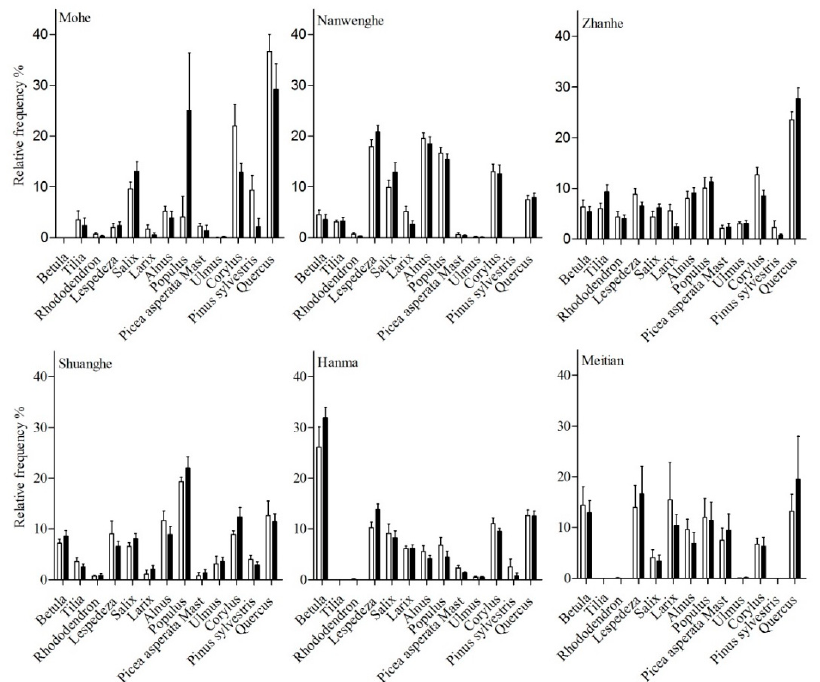
Figure A1. Dry weight (DW; %) of female (white) and male (black) moose diet in Mohe, Nanwenghe, Zhanhe, Shuanghe, Hanma, and Meitian: Betula ; Tilia , Rhododendron , Lespedeza , Salix , Larix , Alnus , Populus , Picea asperata Mast., Ulmus , Corylus , Pinus sylvestris , Quercus.